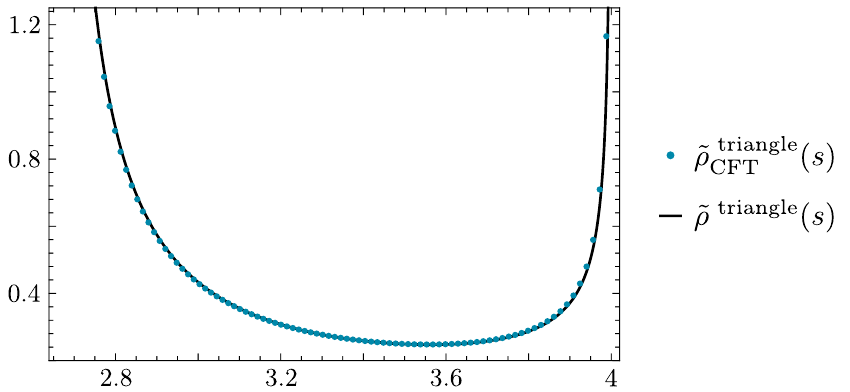
Figure 8 . Comparison between the amplitude’s spectral density below threshold ˜ ρ triangle ( s ) and large dimension ( ∆ = 500 ) numerical CFT density ˜ ρ triangle 1